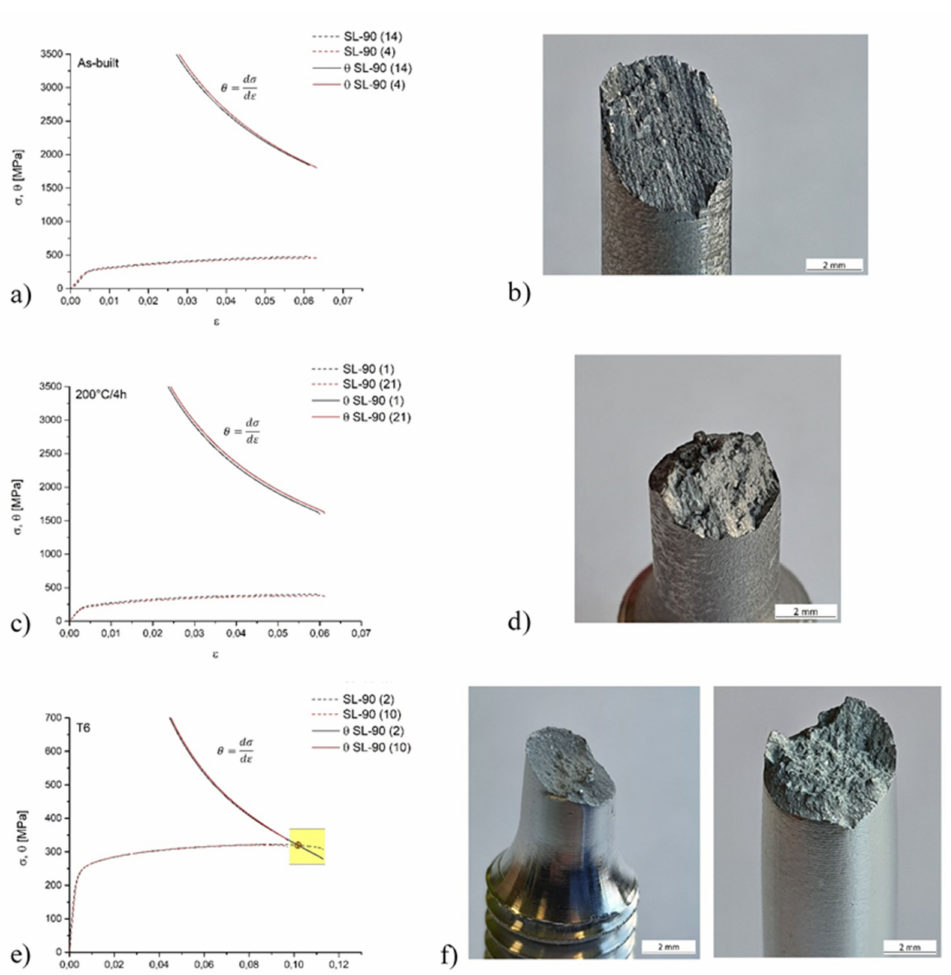
Figure 7. True tensile stress-strain curves and strain hardening rate θ ( a , c , e ) of SL-90 AlSi10Mg samples in as-built condition ( a , b ), after the direct aging ( c , d ) and the T6 heat treatment ( e , f ). Frac- ture surfaces of: ( b ) sample (4) in as-built condition, ( d ) sample (21) heat-treated at 200 ◦ C/4 h, ( f ) samples (10) and (2) T6 heat-treated,